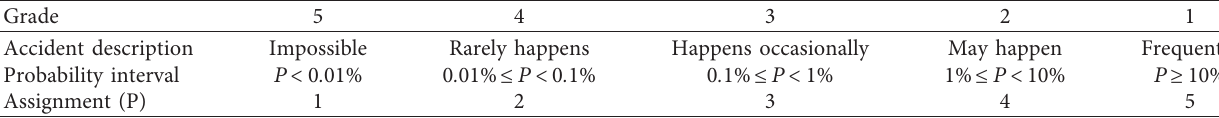
Table 4: The occurrence likelihood grades.